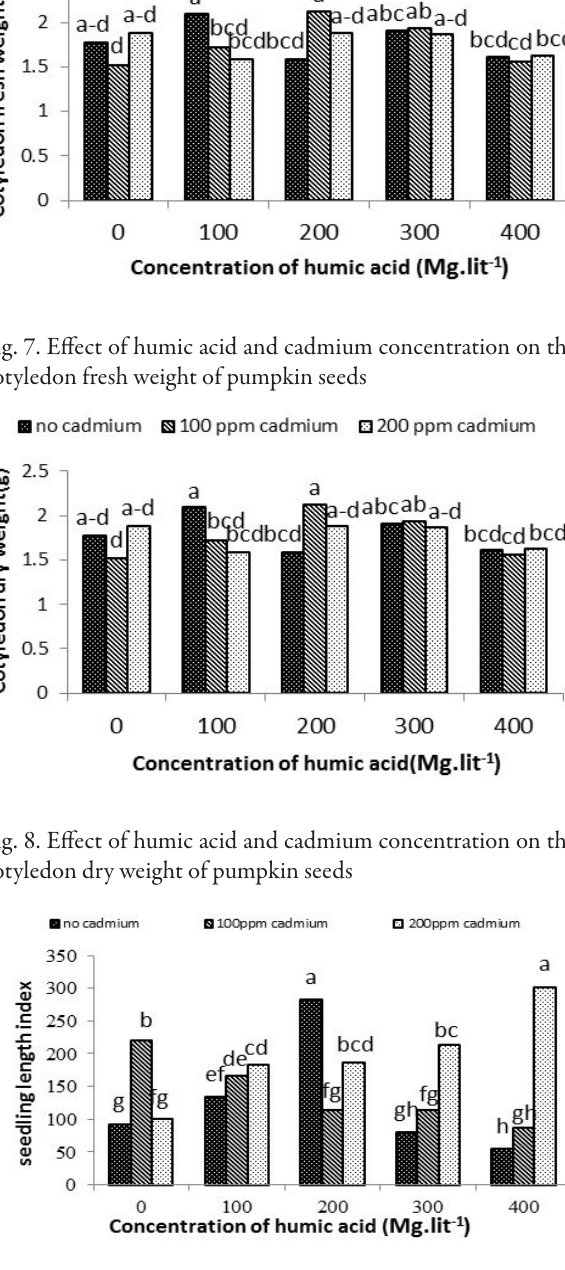
Fig. 9. Effect of humic acid and cadmium concentration on the length index of pumpkin